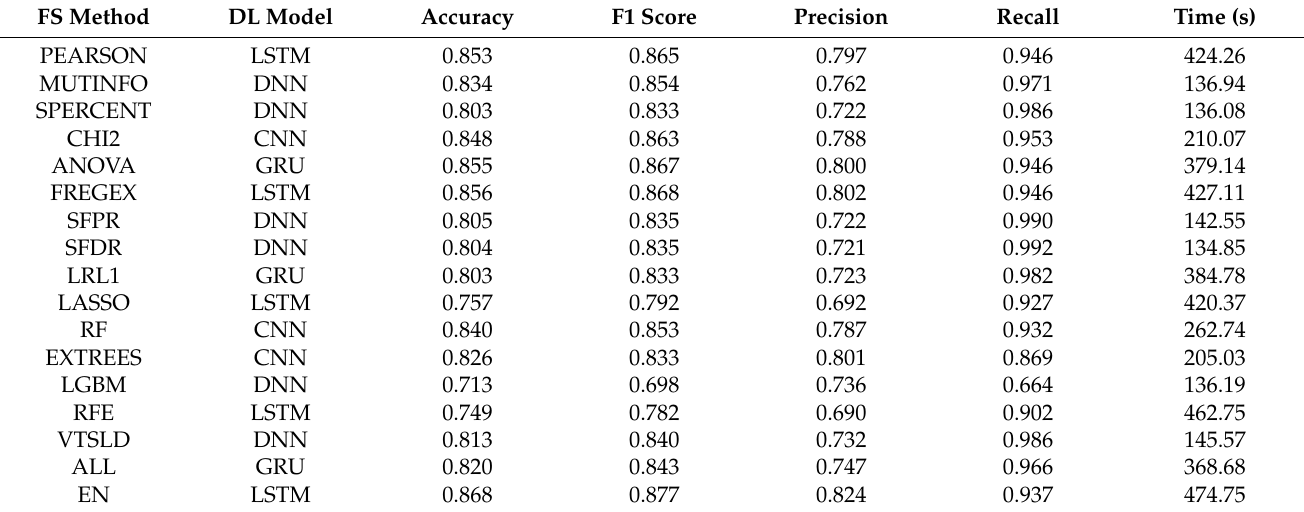
Table 9. Individual FS method best performance summary in deep learning.